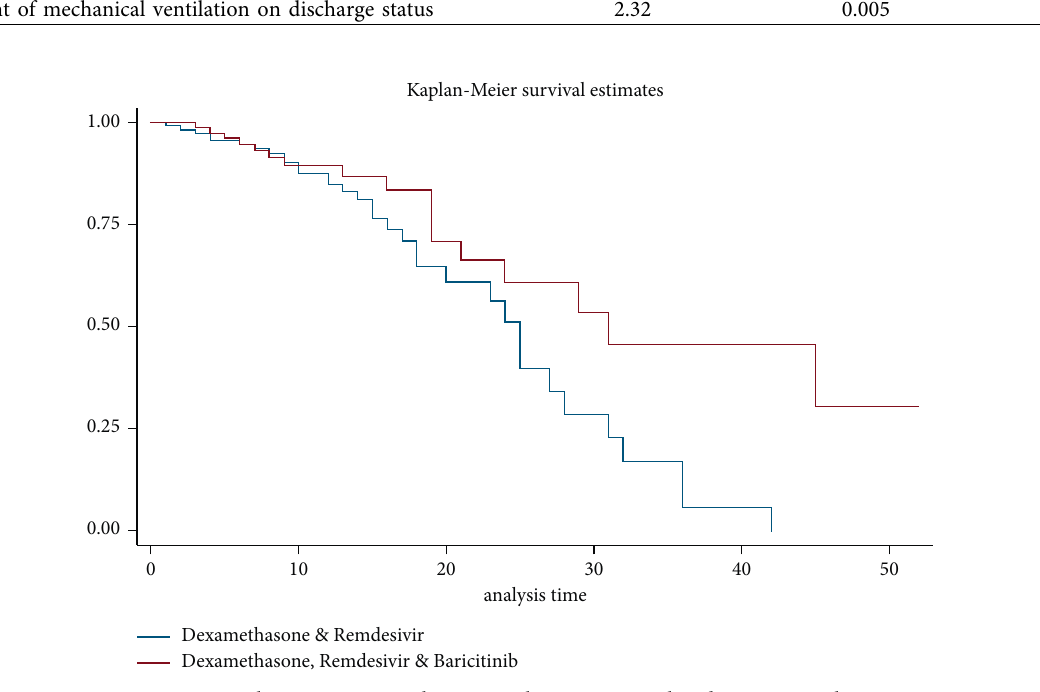
Figure 1: Kaplan–Meier survival estimates between control and experimental arms.